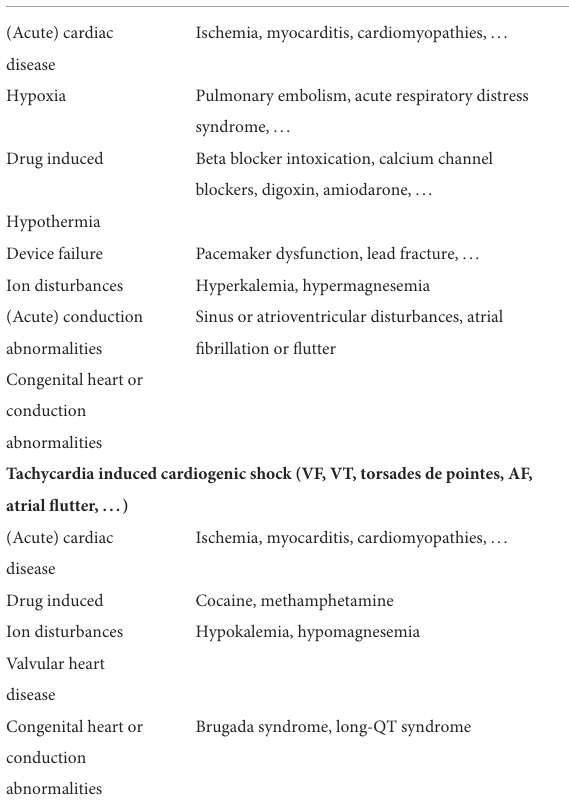
patients with tachyarrhythmia and dilated cardiomyopathy of no clear etiology